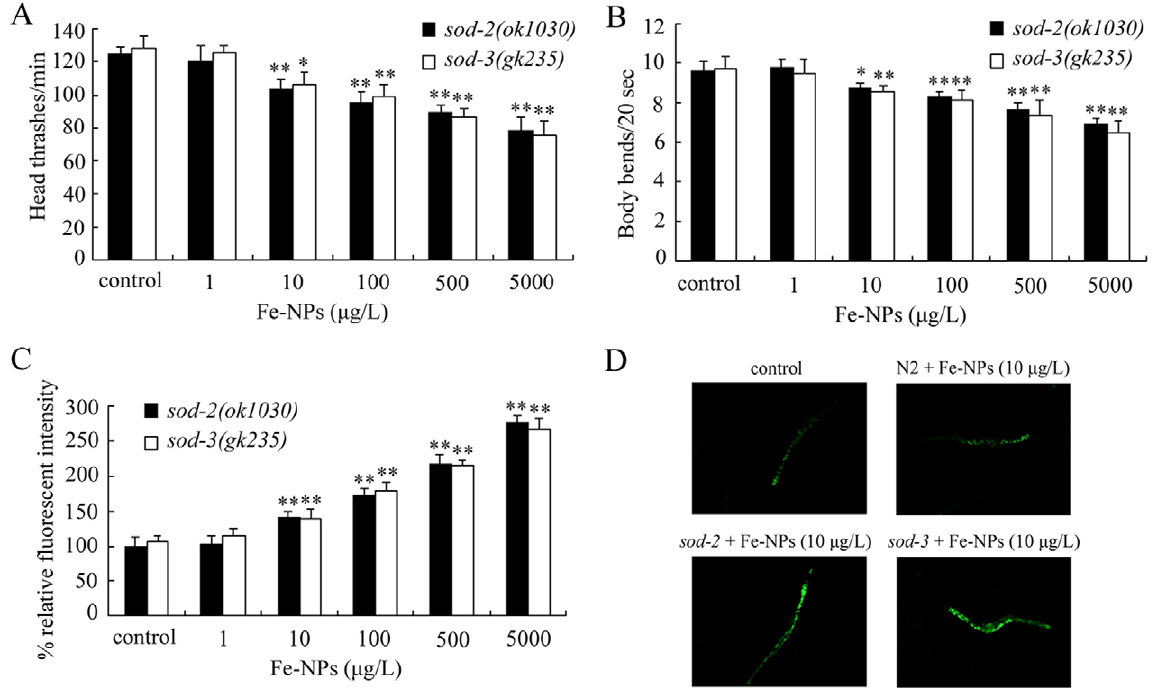
Figure 5. Effects of sod-2 and sod-3 mutations on locomotion behavior and ROS production in nematodes exposed to DMSA coated Fe 2 O 3 -nanoparticles from L1-larvae to day-8 adult. (A) Effects of sod-2 and sod-3 mutations on head thrashes of nematodes exposed to DMSA coated Fe 2 O 3 -nanoparticles. (B) Effects of sod-2 and sod-3 mutations on body bends of nematodes exposed to DMSA coated Fe 2 O 3 -nanoparticles. (C) Effects of sod-2 and sod-3 mutations on ROS production in nematodes exposed to DMSA coated Fe 2 O 3 -nanoparticles. (D) Pictures showing the ROS production in nematodes exposed to Fe 2 O 3 -nanoparticles. Bars represent mean 6 S.E.M. * p , 0.05, ** p , 0.01.